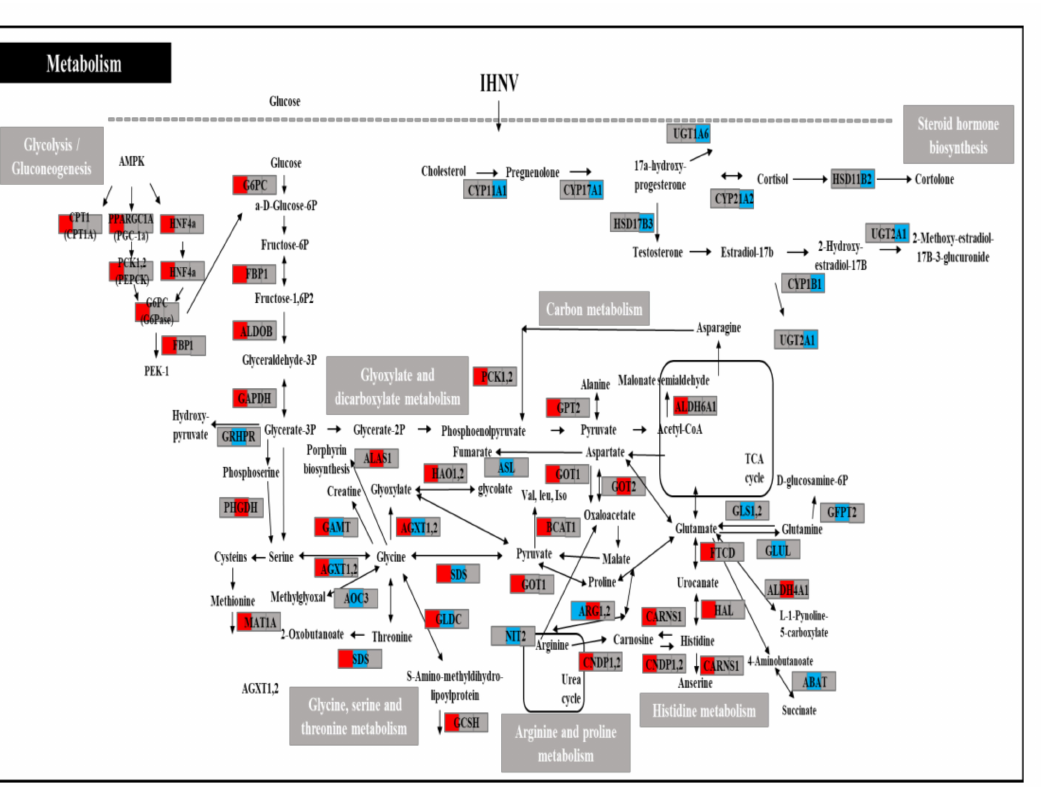
Figure 3. Presentation of putative metabolism-related pathways on days 1, 3, and 5 in the IHNV- infected group. DEGs regulated by the IHNV infection are shown in red (upregulated) or blue (downregulated). The box is divided into three spaces, indicating the up- and downregulated genes on days 1, 3, and 5. The black arrows show the activation and regulatory responses of downstream pathways.